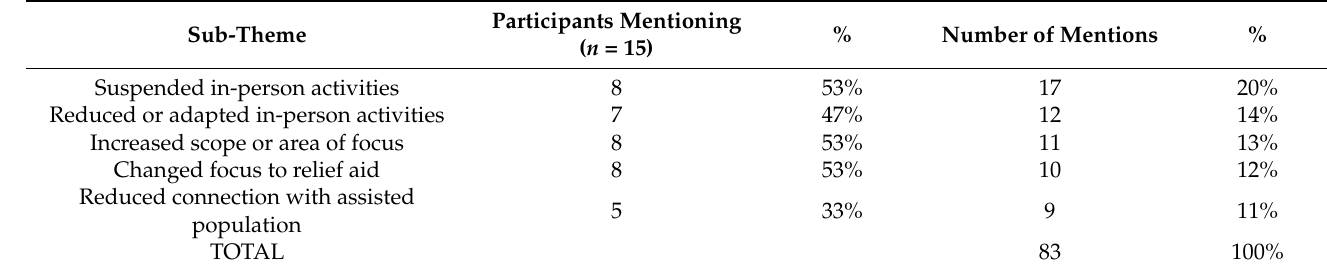
Table 3. Effects of the COVID-19 pandemic on CSOs’